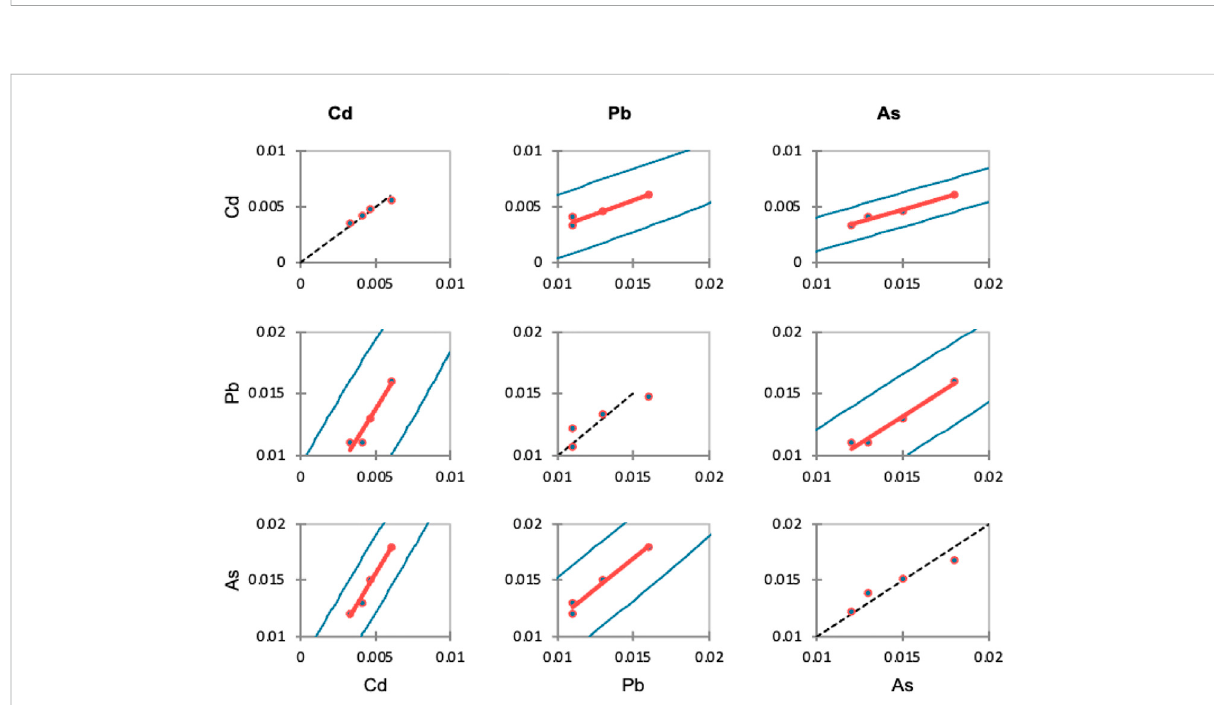
FIGURE 7 Scatter plots: linear regression model indicating the relationship among the various physicochemical parameters of the Veshaw stream.